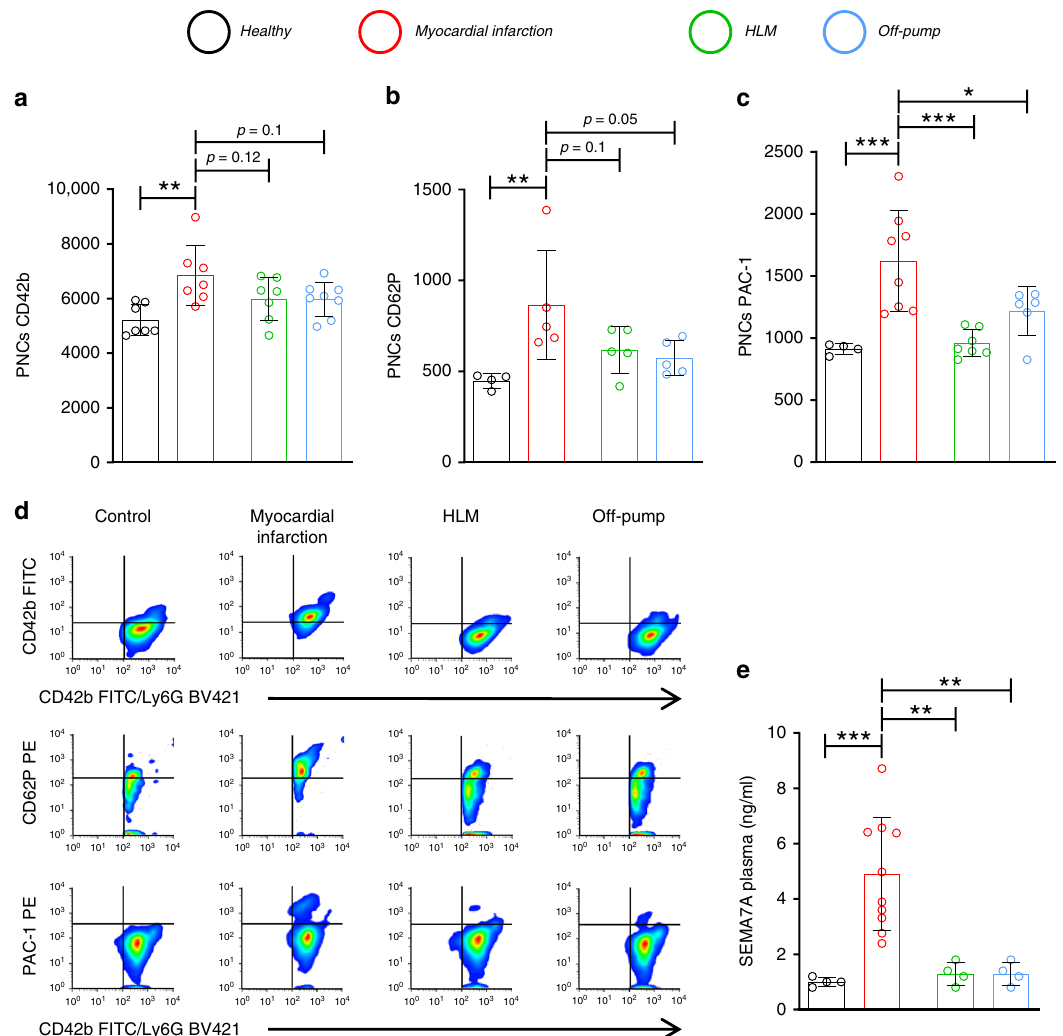
Fig. 1 Patients with acute myocardial infarction show increased PNCs and plasma SEMA7A. Samples were taken from patients with acute myocardial infarction, patients undergoing cardiac surgical operations with (HLM) or without cardiopulmonary bypass (Off-Pump) and healthy controls. a Flow- cytometric evaluation of PNCs ’ expression of GPIb (CD42b) in the presented patient groups (Healthy, MI, and HLM n = 7; Off-pump n = 8). b Flow- cytometric evaluation of PNCs for CD62P expression on neutrophils ( n = 4;5;5;5). c PAC-1 binding to PNCs ( n = 4;8;7;6). d Representative fl ow-cytometric histograms of groups measured and e Sema7a in the plasma of patients with acute MI ( n = 10), patients undergoing cardiac surgical operations with (HLM) or without cardiopulmonary bypass (Off-Pump) and healthy controls (all n = 4/group). For comparison we performed one-way analyzes of variance followed by Dunnett ’ s tests to group myocardial infarction. Data are mean ± SD; * p < 0.05, ** p < 0.01, and *** p < 0.001 as tissue injury in Sema7a − / − animals compared to littermate (Supplementary Fig. 6 and Supplementary Video 1). This is consistent with our previous fi ndings that Sema7a expressed on controls and a reduced number of PNCs in the tissue areas at risk the surface of endothelial cells increases the transmigration of (Fig. 3e, f). Flow-cytometric analysis revealed decreased numbers neutrophils into in fl amed tissues 19 . of PNCs (Fig. 3j) in the blood of Sema7a − / − animals compared to controls, and the conjugates displayed lower levels of platelet activation markers (surface P-Selectin and activated integrin α IIb β 3 (JON/A)) in the early phase after IR (Fig. 3g – i, Supple- mentary Fig. 9a, b). We again tested whether this would be re fl ected within the PNCs in the AAR. We extracted this area and counted the PNCs within the myocardial tissues. Using fl ow cytometry, we found reduced number of PNCs within the AAR and the conjugates displayed decreased signals for GPIb, activated integrin α IIb β 3 and P-Selectin on neutrophils in the AAR of Sema7a − / − animals (Fig. 3k – n, Supplementary Fig. 9c, d). Red blood cell-derived semaphorin 7a is central to MIRI . Next,